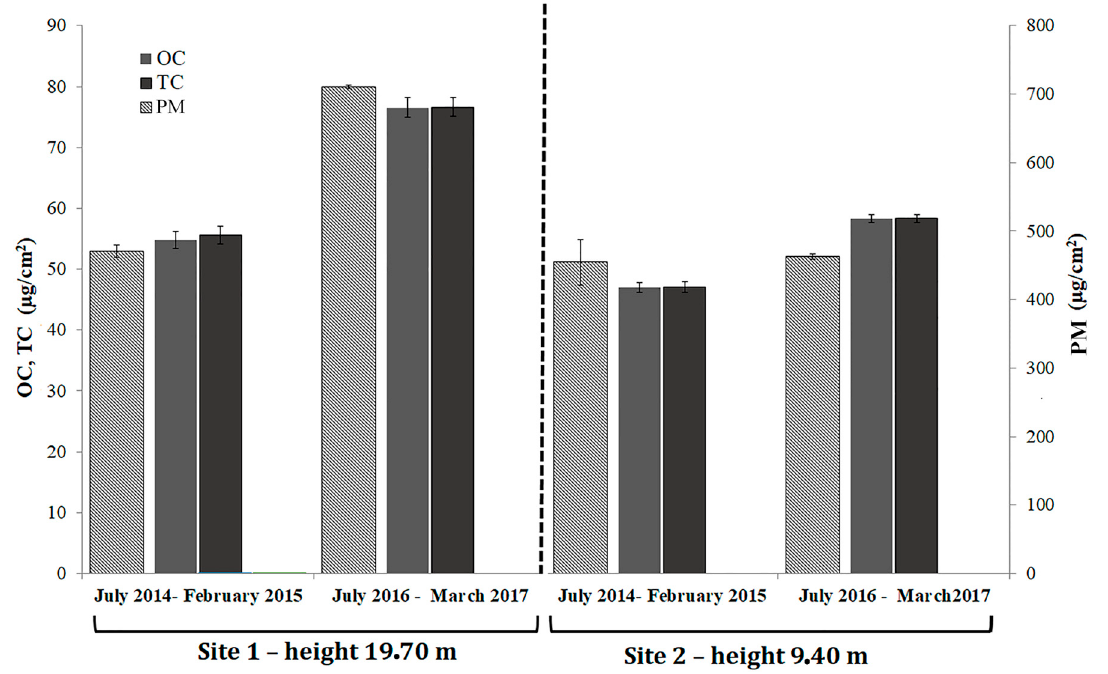
Figure 10. OC (organic carbon), TC (total carbon) and PM weights determined on quartz fiber filters exposed in the two sites on the Duomo façade for two periods. Geosciences 2018 , 8 , x FOR PEER REVIEW 14 of 18